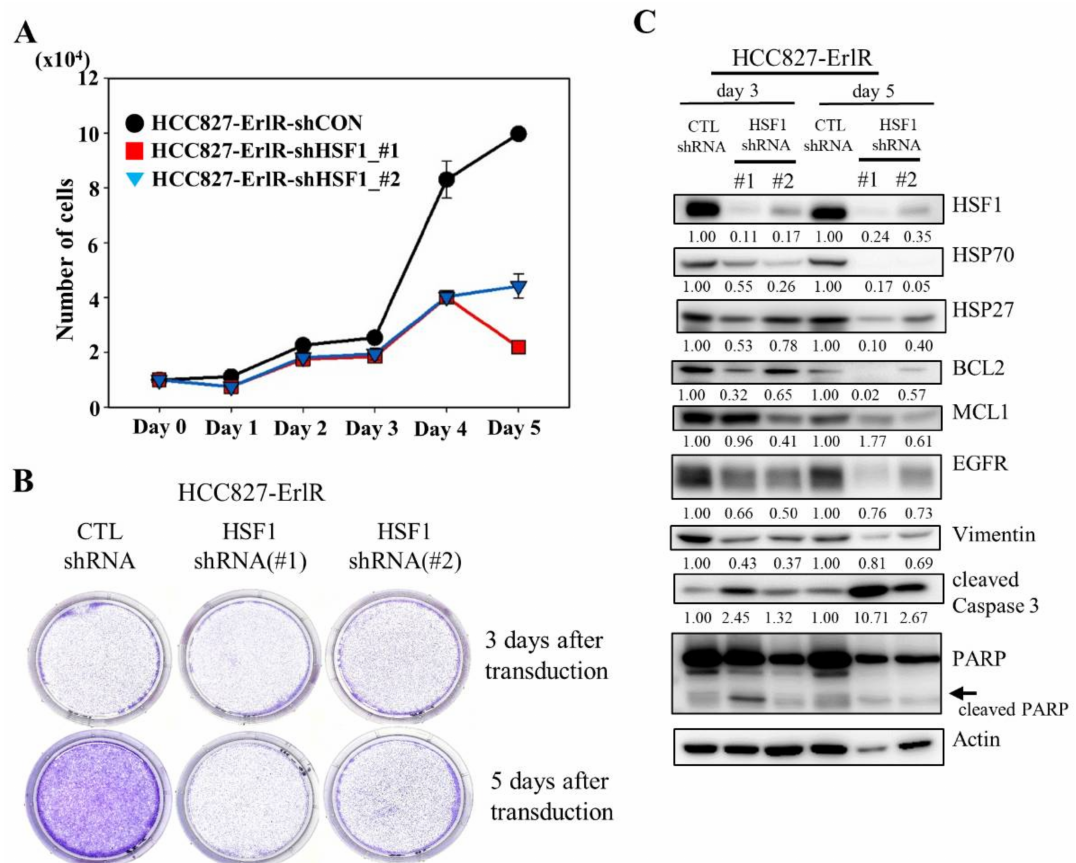
Figure 3. The shRNA-mediated knockdown of HSF1 inhibits the proliferation and colony formation of HCC827-ErlR cells. ( A ) HCC827-ErlR cells were transduced with lentivirus carrying shRNA targeting HSF1 (#1 or #2) or control shRNA. Twenty- four hours after transduction (day 0), cells were counted using a microscope on the designated days. ( B ) Representative images are shown of colonies formed by HCC827-ErlR cells transduced with control shRNA, HSF1 shRNA (#1), or HSF1 shRNA (#2) after 3 or 5 days of transduction. ( C ) HCC827-ErlR cells were transduced with control shRNA, HSF1 shRNA (#1), or HSF1 shRNA (#2), and whole cell lysates were prepared 3 and 5 days after transduction. Expression of HSF1 or its downstream proteins was analyzed by Western blotting using the indicated antibodies (protein band intensity was normalized to the actin band